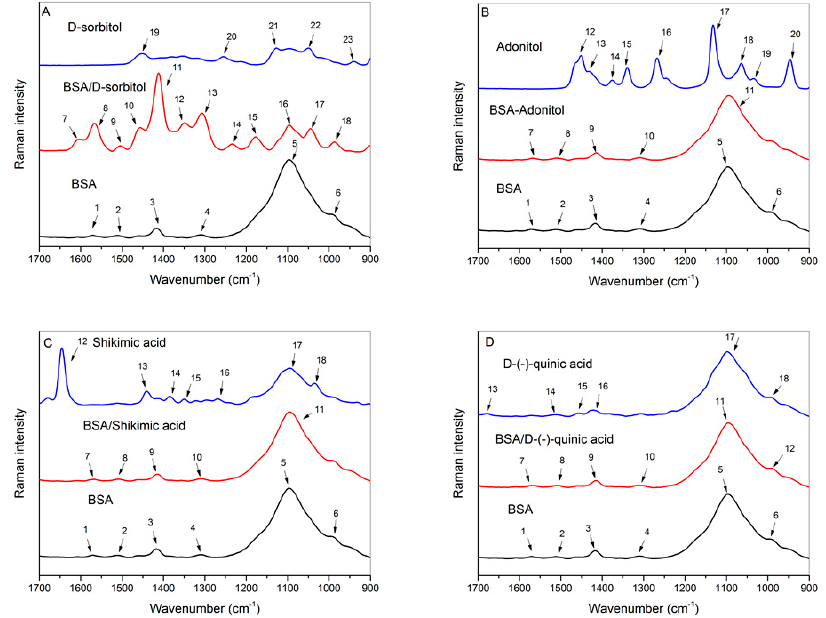
Figure 7 . Raman spectra of BSA, the cyclitols, and their complexes (at a 1:10 molar ratio) in the range of 1700–900 cm − 1 : ( A ) D-sorbitol; ( B ) adonitol; ( C ) shikimic acid; and ( D ) D-(–)-quinic acid.